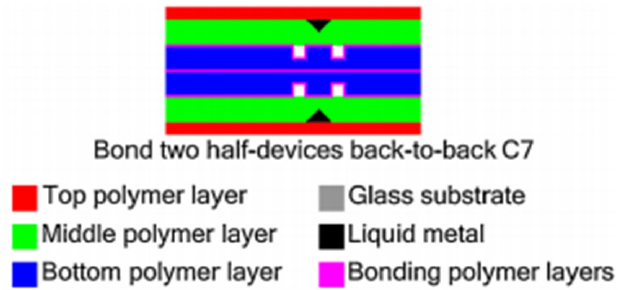
Figure17. Figure 17. The construction stack of liquid metal embedded elastomer curvature sensor [136] (Open Access).